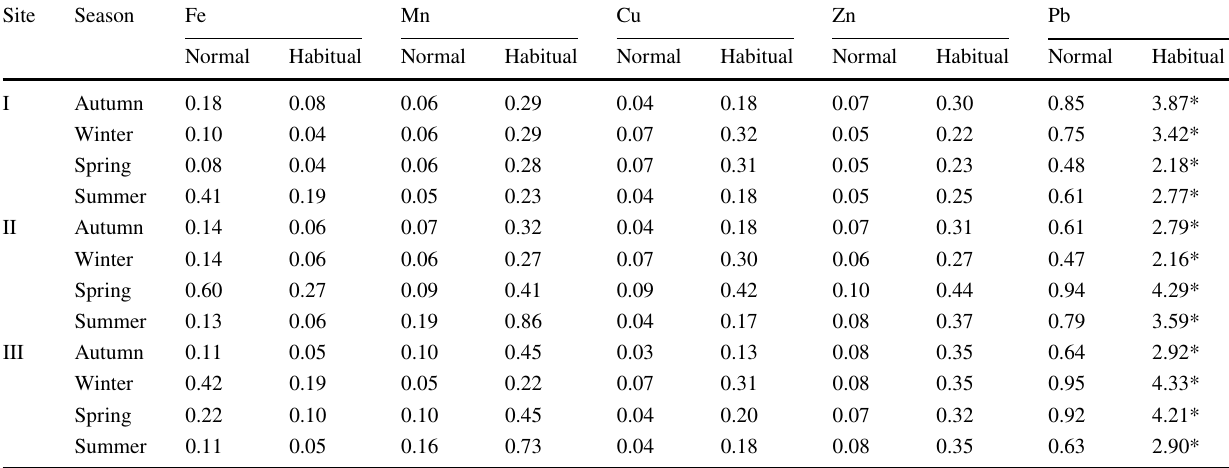
Table 6 Hazard index for liver of O. niloticus at mean ingestion rate (0.0312 kg/day) and subsistence ingestion rate (0.1424 kg/day)